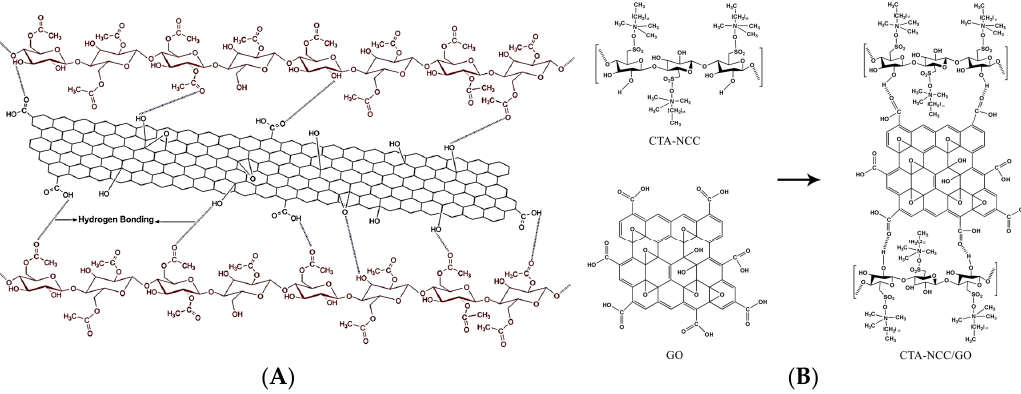
Figure 8. ( A ) Schematic interaction of CNCA/GO. Reproduced with permission from Reference [156].